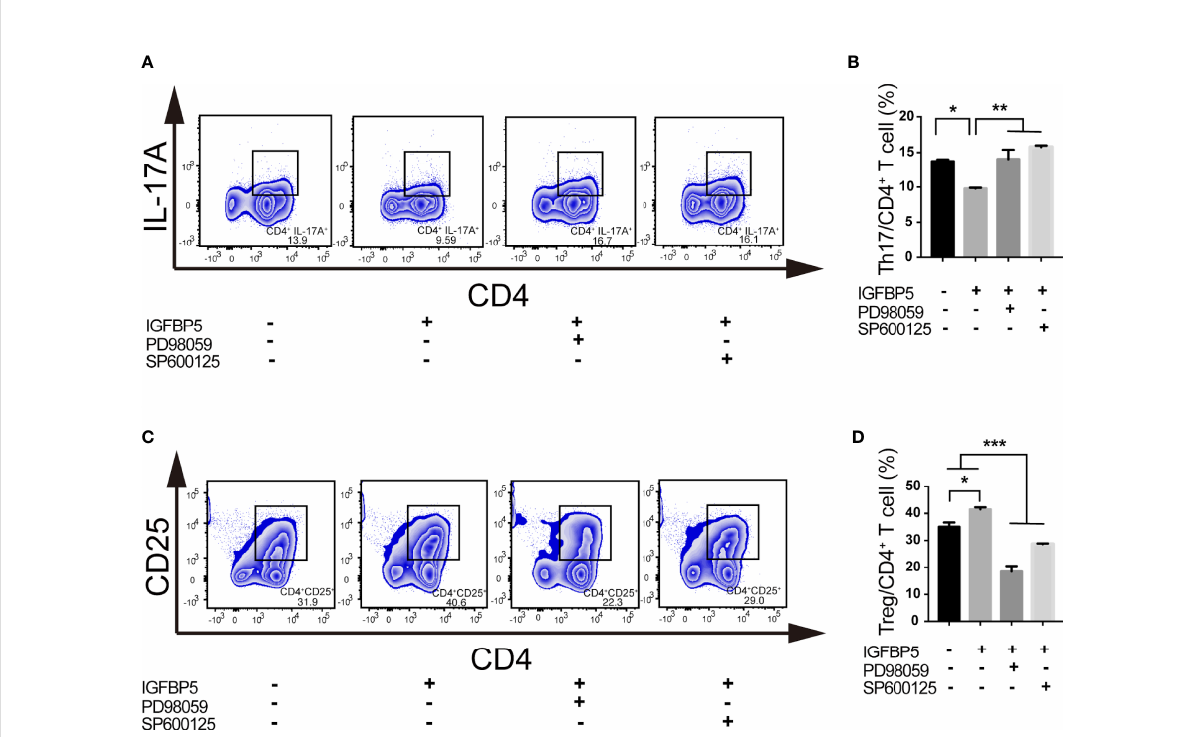
FIGURE 5 IGFBP5 regulated the balance of Th17/Treg partly through ERK and JNK pathways. Flow cytometry was used to investigate the key mechanisms of IGFBP5-mediated Th17/Treg ratio change under the pretreatment of ERK and JNK pathway inhibitors, PD98059 and SP600125, before IGFBP5 treatment. (A, B) Flow cytometry showed that the percentage of CD4 + IL-17A + Th17 cells in the CD3/CD28 activated T cells increased with the presence of PD98059 and SP600125. (C, D) Flow cytometry showed that the percentage of CD4 + CD25 + Treg cells in the CD3/CD28 activated T cells decreased with the presence of PD98059 and SP600125. The experiment was repeated three times independently. One-way ANOVA was used to determine statistical signi fi cance. The data are presented as the mean ± SEM (n=3). * p < 0.05, ** p < 0.01, *** p <